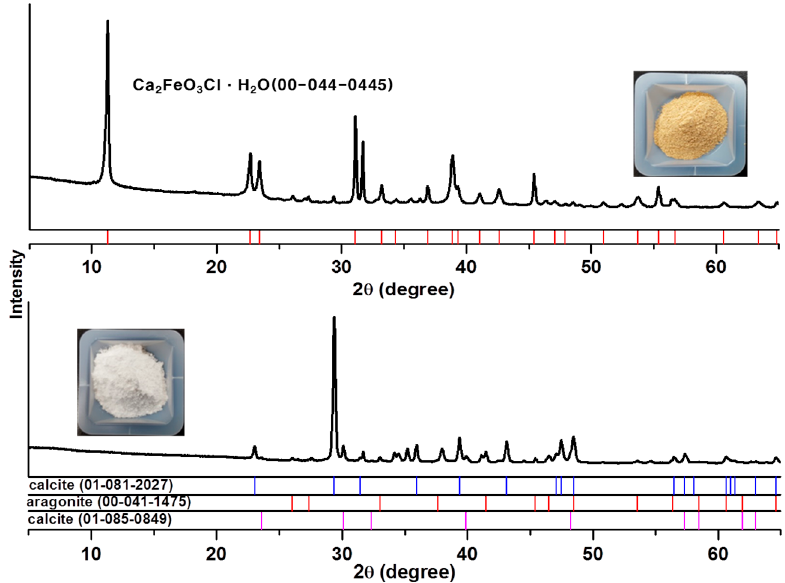
Figure 6. XRD patterns of reddish-brown and white precipitates with increasing pH of the filtrate obtained by the reaction of 20% AR. Magnified photographs of two powders from Figure 1 are also shown. Table 5. Analysis methods and elemental concentrations of the precipitates formed with increasing pH of the filtrate with 20% AR.